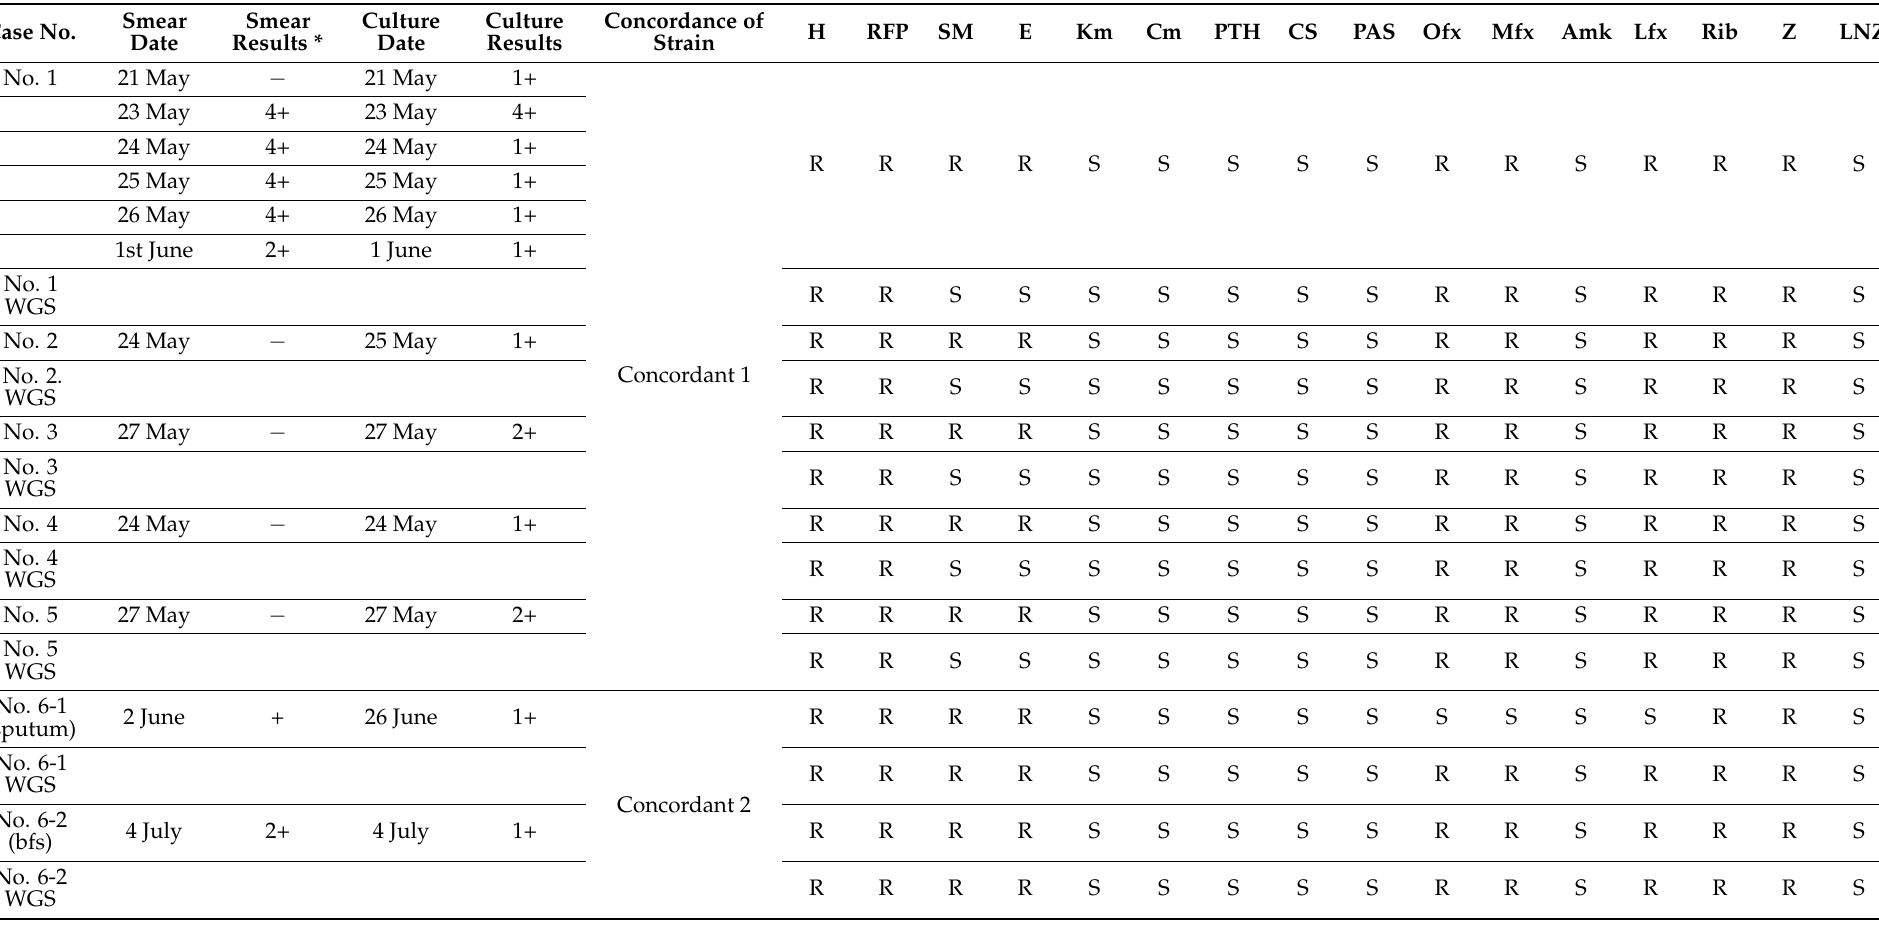
Table 1. True and false positive results of the AFB smear, AFB culture, and drug resistance reports by pDST and WGS. Case